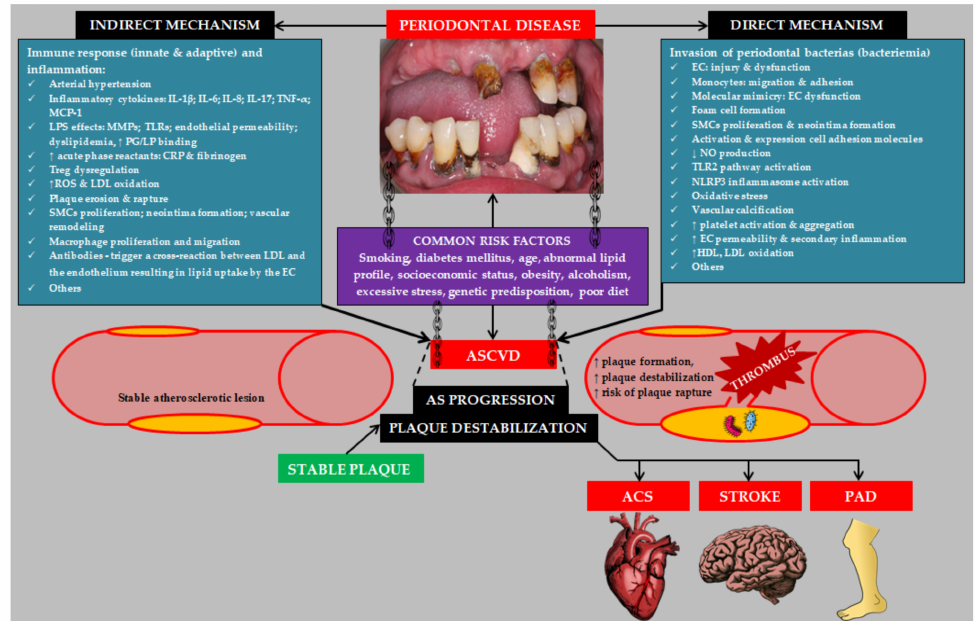
Figure 2. Etiopathogenesis of atherosclerotic cardiovascular disease induced by periodontal